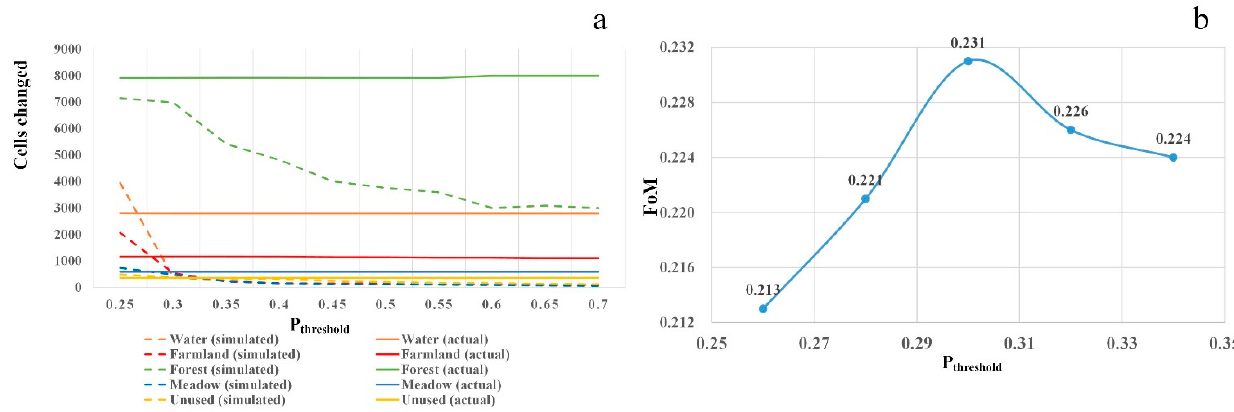
Figure 8. Model performance of different transition possibility threshold P threshold values. ( a ) relationship between the cell number changed (simulated vs. actual) and different P threshold ; ( b ) relationship between P threshold and FoM.